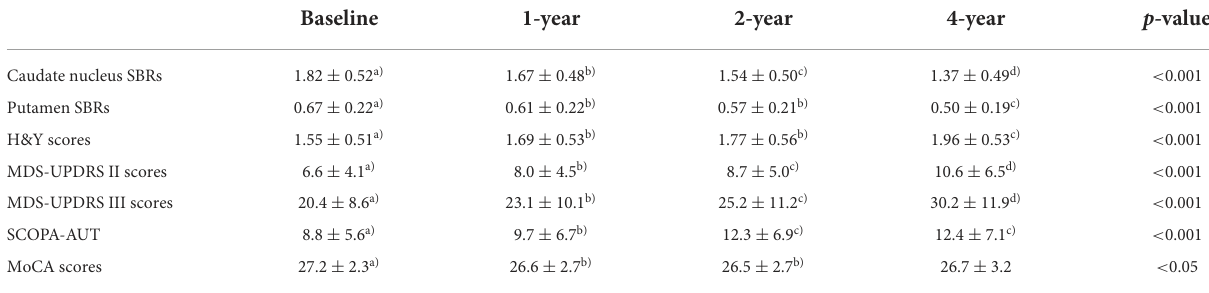
TABLE 2 Clinical data of the PD group at each follow-up timepoints.